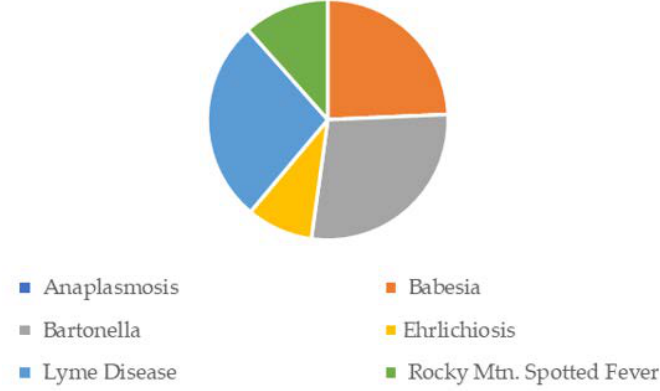
Figure 6. Facial/Bell’s Palsy Symptom Frequency, by TBD.